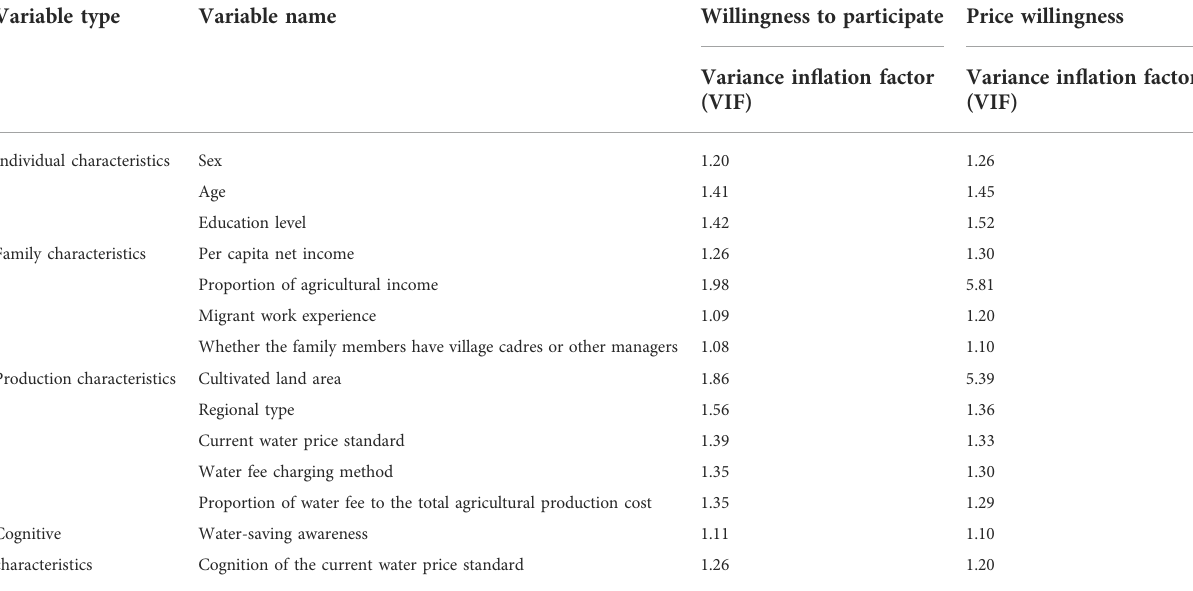
TABLE 4 Multi-collinearity test results on the explanatory variables.